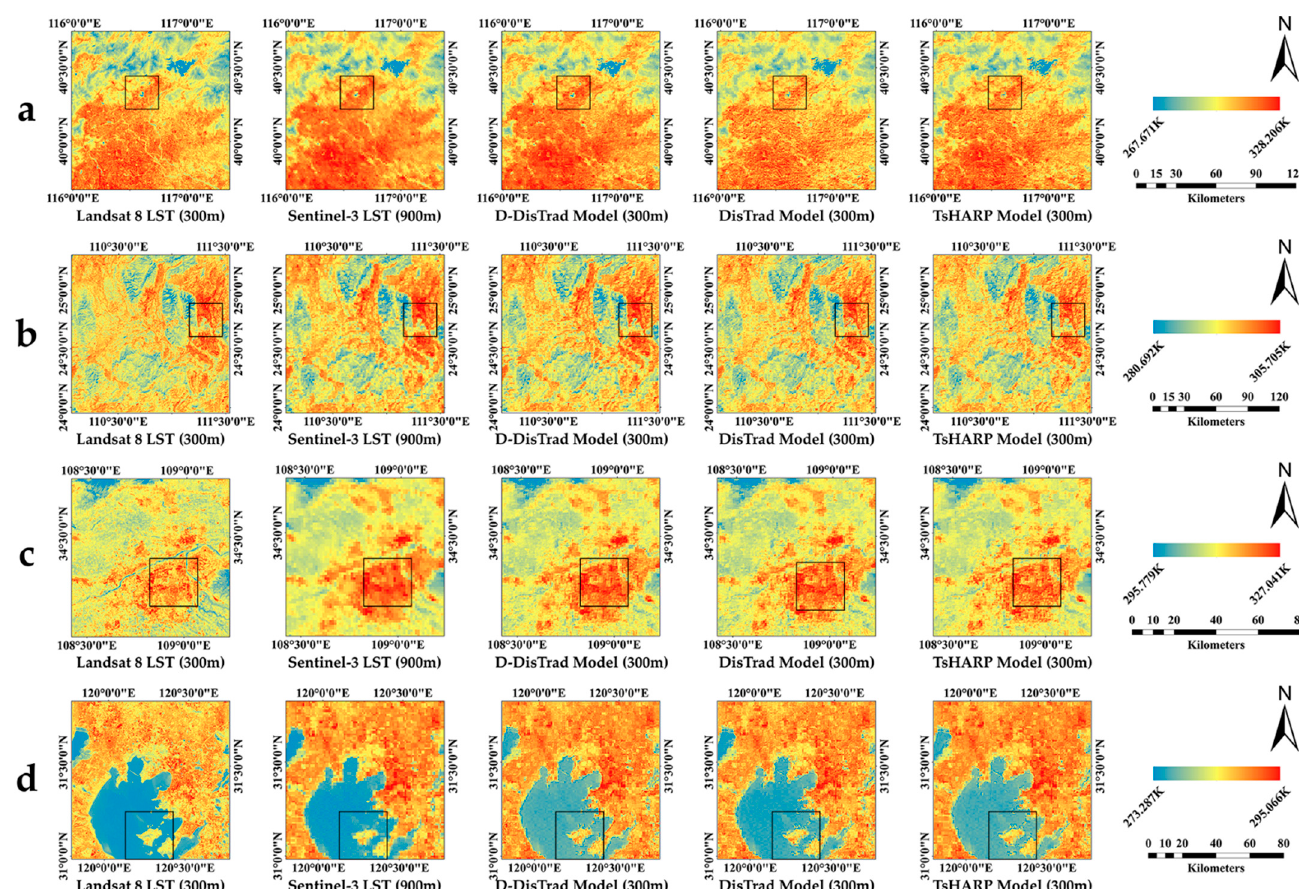
Figure 3. Each line goes from left to right, showing the Landsat 8 LST, SLSTR LST, D-DisTrad LST, DisTrad LST, and TsHARP LST data for the 4 study sites: ( a ) site 1, Beijing; ( b ) site 2, Guilin; ( c ) site 3, Xi’an–Xian Yang; ( d ) site 4, Taihu River Basin. The black box shows the selected areas of noticeable